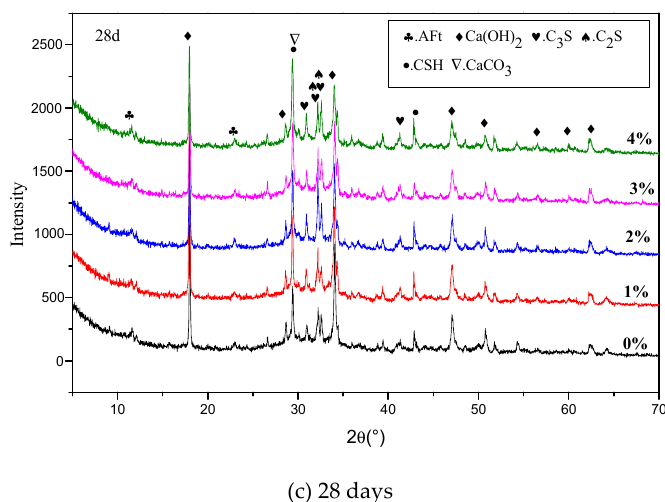
Figure 7. XRD spectrum results of the mixes with different contents of NaHCO 3 at ages of ( a ) 1, ( b ) 7, and ( c ) 28 days.